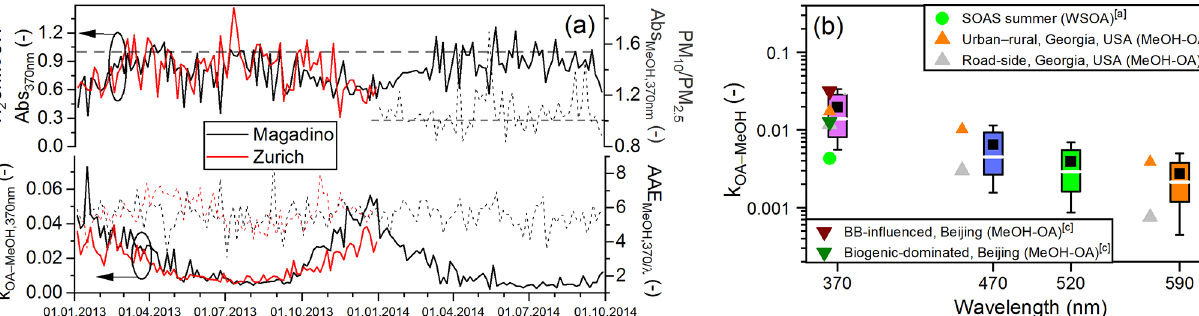
both sites. The full dataset absorption Ångström